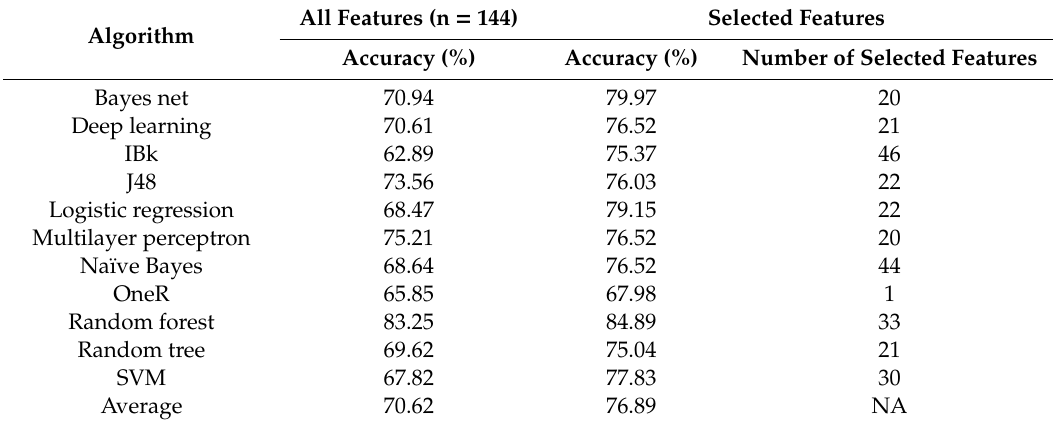
Table 3. Classification accuracy from 11 ML algorithms classifying data into three classes before and after feature